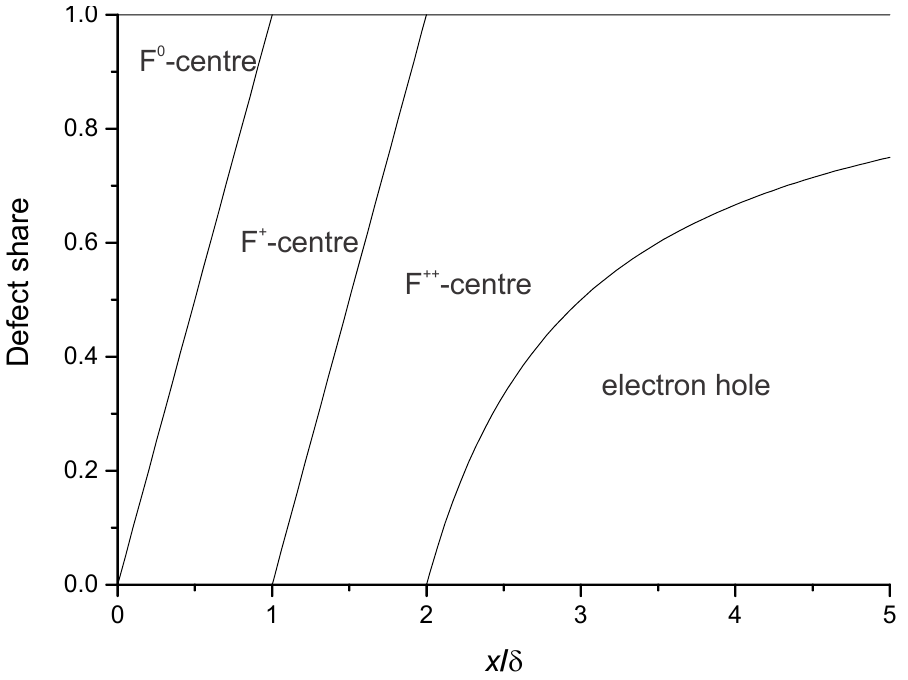
Figure 1. Share of F-type centres and electron holes in La 1 − x Sr x ScO 3 − δ (Graphical representation of Table 4). Table 5. Oxygen vacancy ( apical or equatorial , Table A1) formation energy in La 1 − x Sr x ScO 3 − δ , in eV per one vacancy. Corresponding spatial distribution of Sr cations as in Tables A3 and A4 and V •• o as in Tables A5–A8. For δ = 0.0625 a single vacancy was introduced as in Tables A5, A6 and A8. For δ = 0.125, a two vacancies were introduced as in Tables A7 and